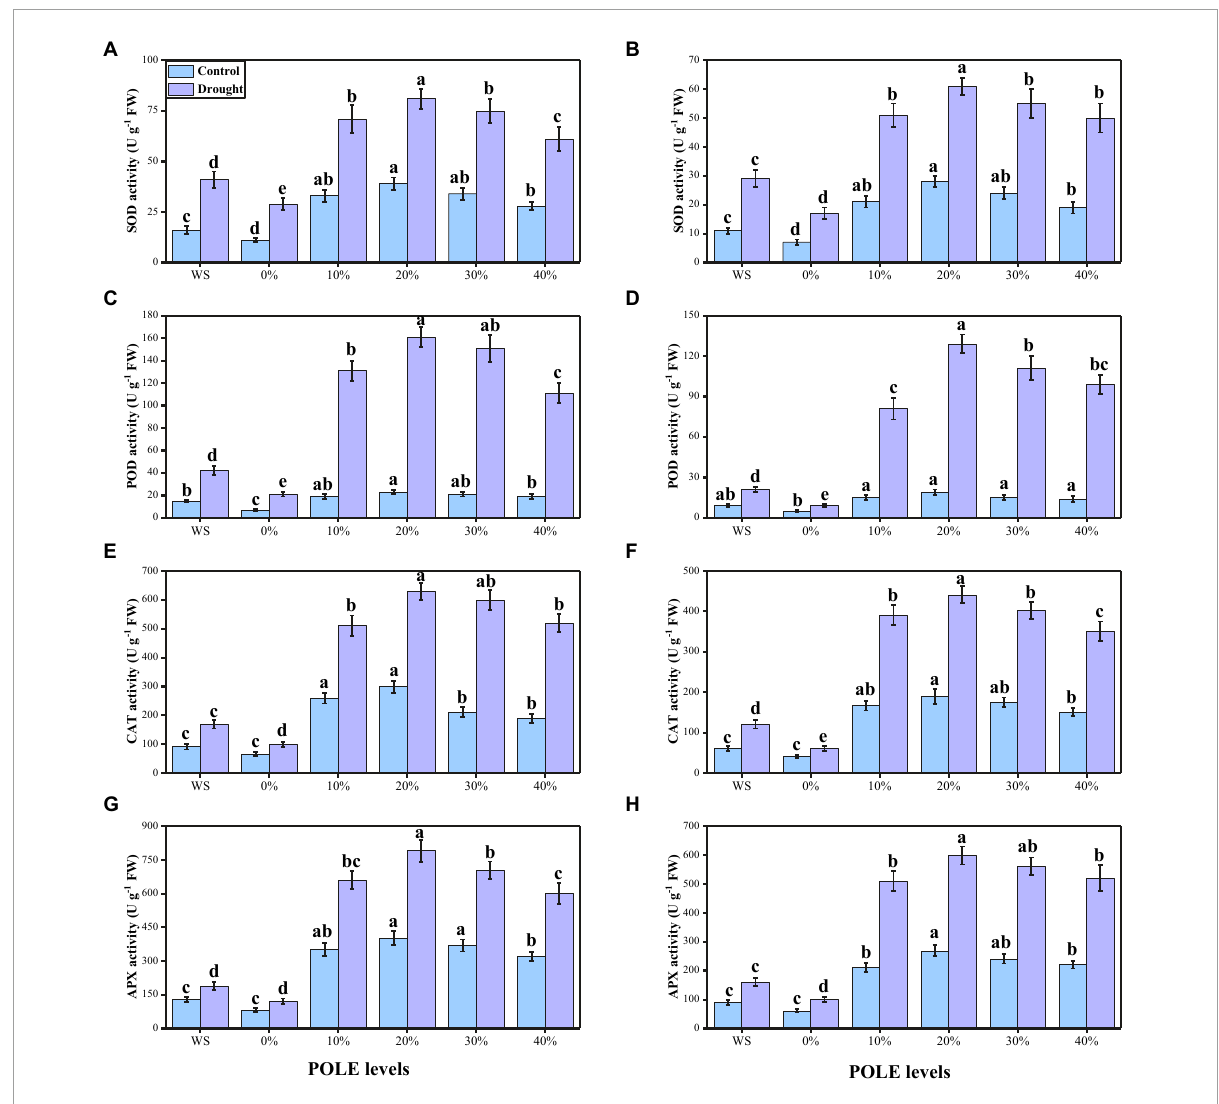
FIGURE6 Effect of seed priming with Plantago ovata Forsk leaf extract (POLE) on SOD activity in the roots (A) , SOD activity in the leaves (B) , POD activity in the roots (C) , POD activity in the leaves (D) , CAT activity in the roots (E) , CAT activity in the leaves (F) , APX activity in the roots (G) , and APX activity in the leaves (H) under well-watered and drought-stressed environment in wheat. Means sharing similar letter(s) within a column for each parameter do not differ significantly at P < 0.05. Data in the figures are means of four repeats ( n = 4) of just one harvest of wheat plants ± standard deviation (SD). Different lowercase letters on the error bars indicate significant difference between the treatments. Different treatments of POLE used in this study are as follows: WS (Control, without POLE + without water), 0% (0% POLE), 10% (10% POLE), 20% (20% POLE), 30% (30% POLE), and 40% (40%